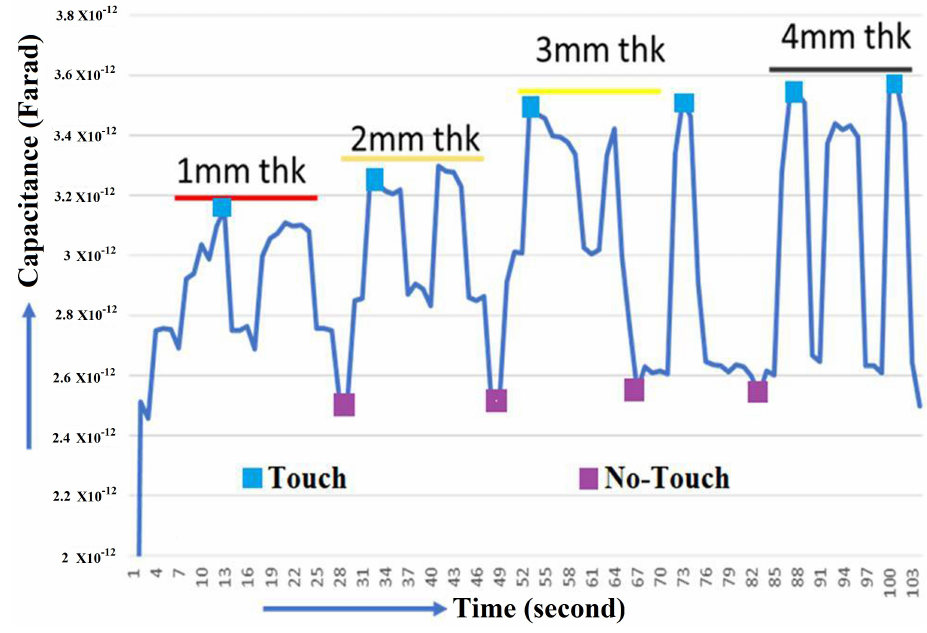
Figure 12. Change in capacitance with respect to thickness of IVI